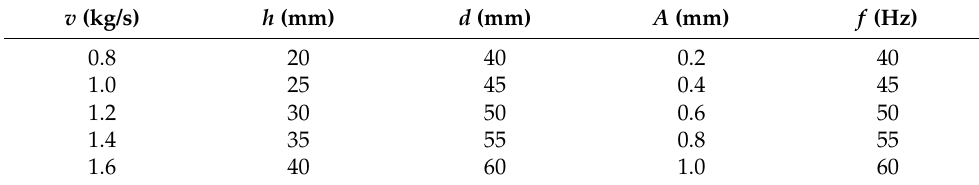
Table 9. Secondary values of each